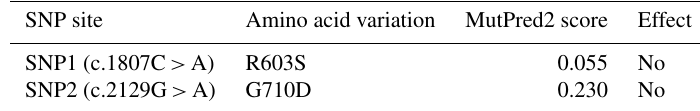
Table 6. Effects of the MLPH gene deleterious nsSNPs on protein tertiary structure. SNP site Amino acid variation MutPred2